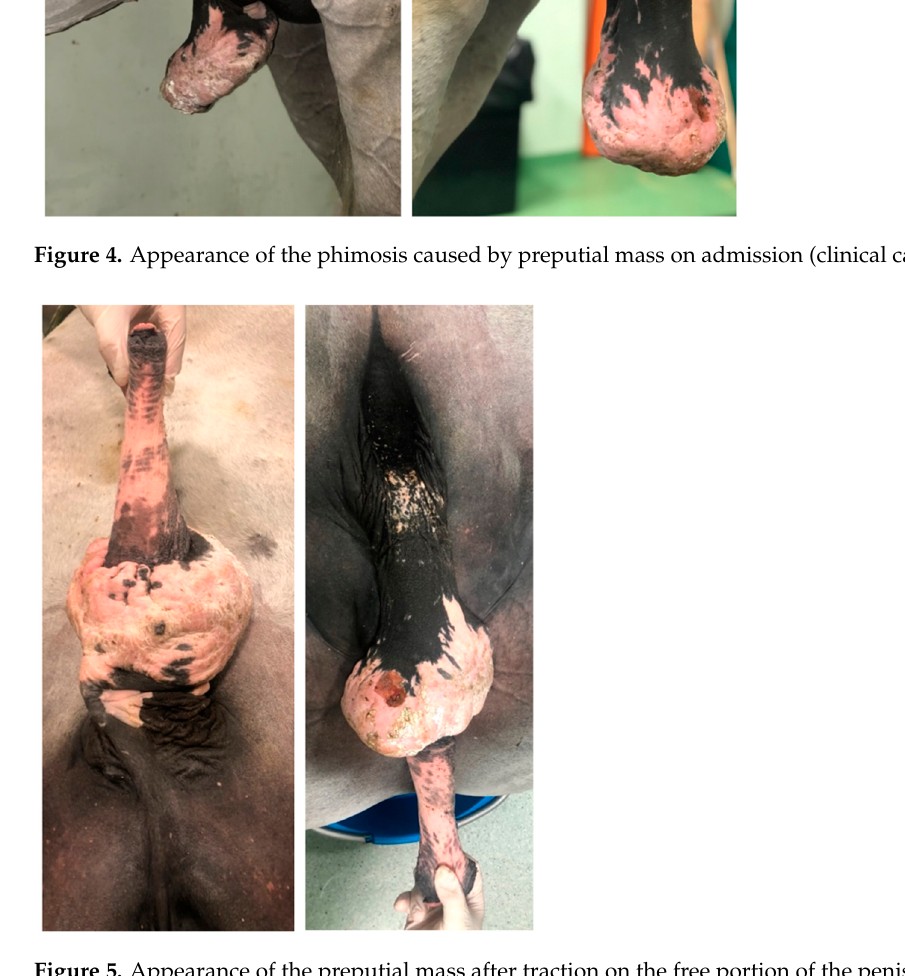
Figure 5. Appearance of the preputial mass after traction on the free portion of the penis, the horse was unable to protrude the penis, through a scarred outer lamina of the internal preputial fold and preputial ring (clinical case